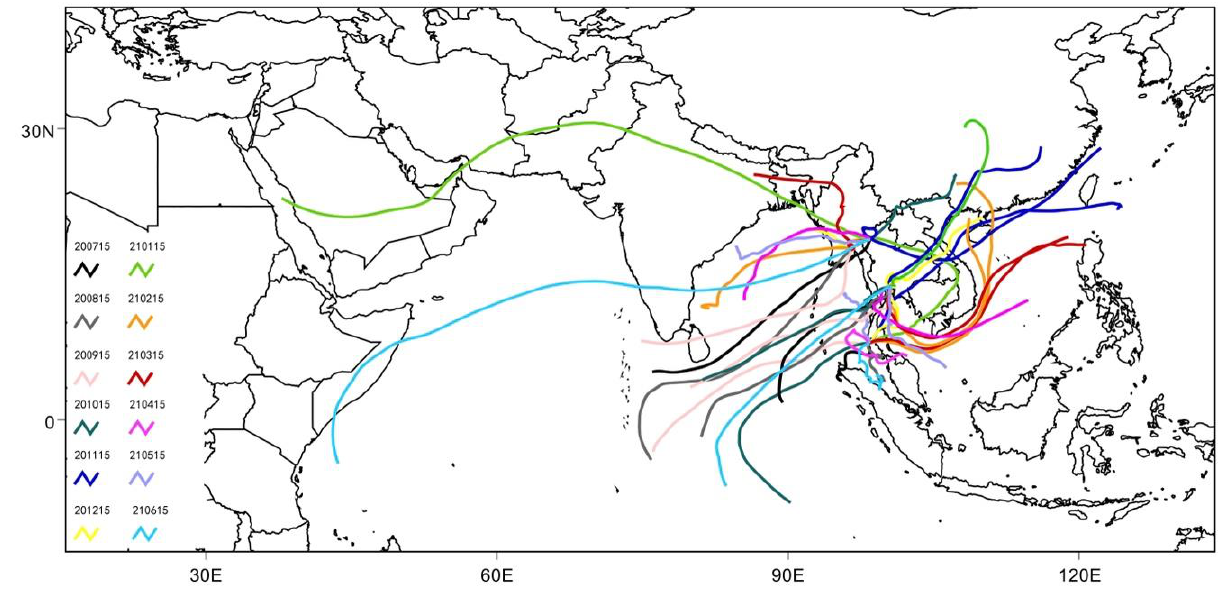
Figure 3. The five-day backward trajectories arriving at the sampling locations named COS (18.54419° N, 98.48085° E), BOS (13.77509° N, 100.50869° E), and POS (7.89407° N, 98.35386° E) at the surface level on the first day of each month from July 2020 to June 2021.